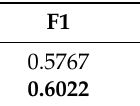
Table 5. Accuracy comparison of change detection results.